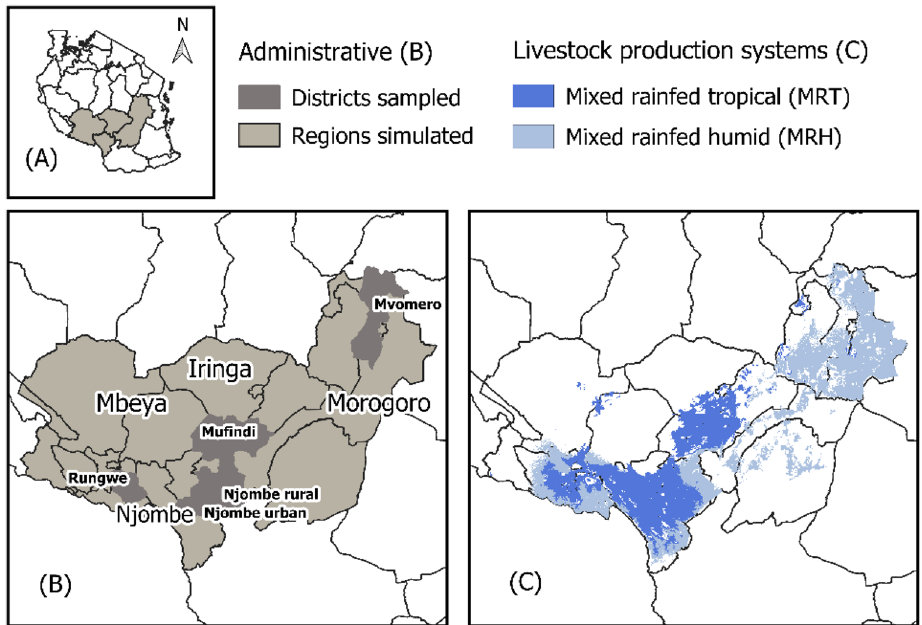
Figure 2. Geographic focus of study. ( A ) Shows the region within which the study focusses. ( B ) Shows the administrative regions (Mbeya, Njombe, Iringa, Morogoro) for which the model simulations were run and the districts (Rungwe, Njombe urban and rural, Mufindi, and Mvomero) the survey sampled from. ( C ) Shows the livestock production systems within which the simulations were conducted. Figure generated in QGIS 3.8.2 36 (https:// www. qgis. org/ en/ site/).